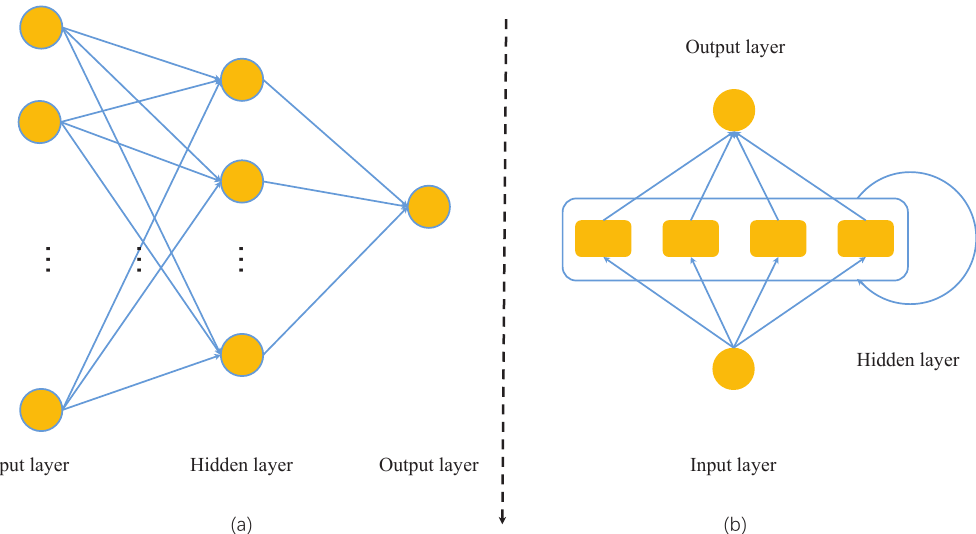
Figure 8. The complete structures of BP neural network and RNNs. ( a ) the structure of BP neural network,